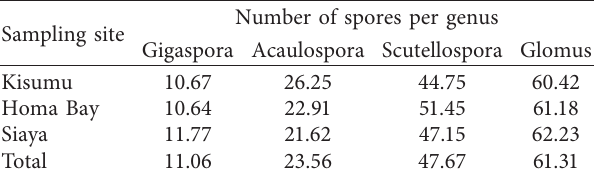
Table 3: Mean spore count of AMF genera in the sampling areas.